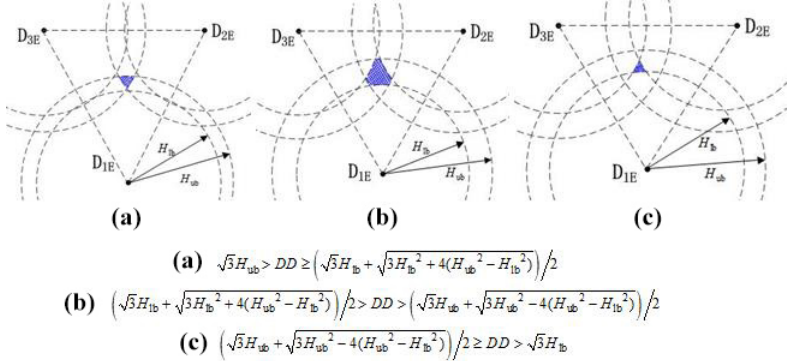
Figure 9. Three categories of type II work space.